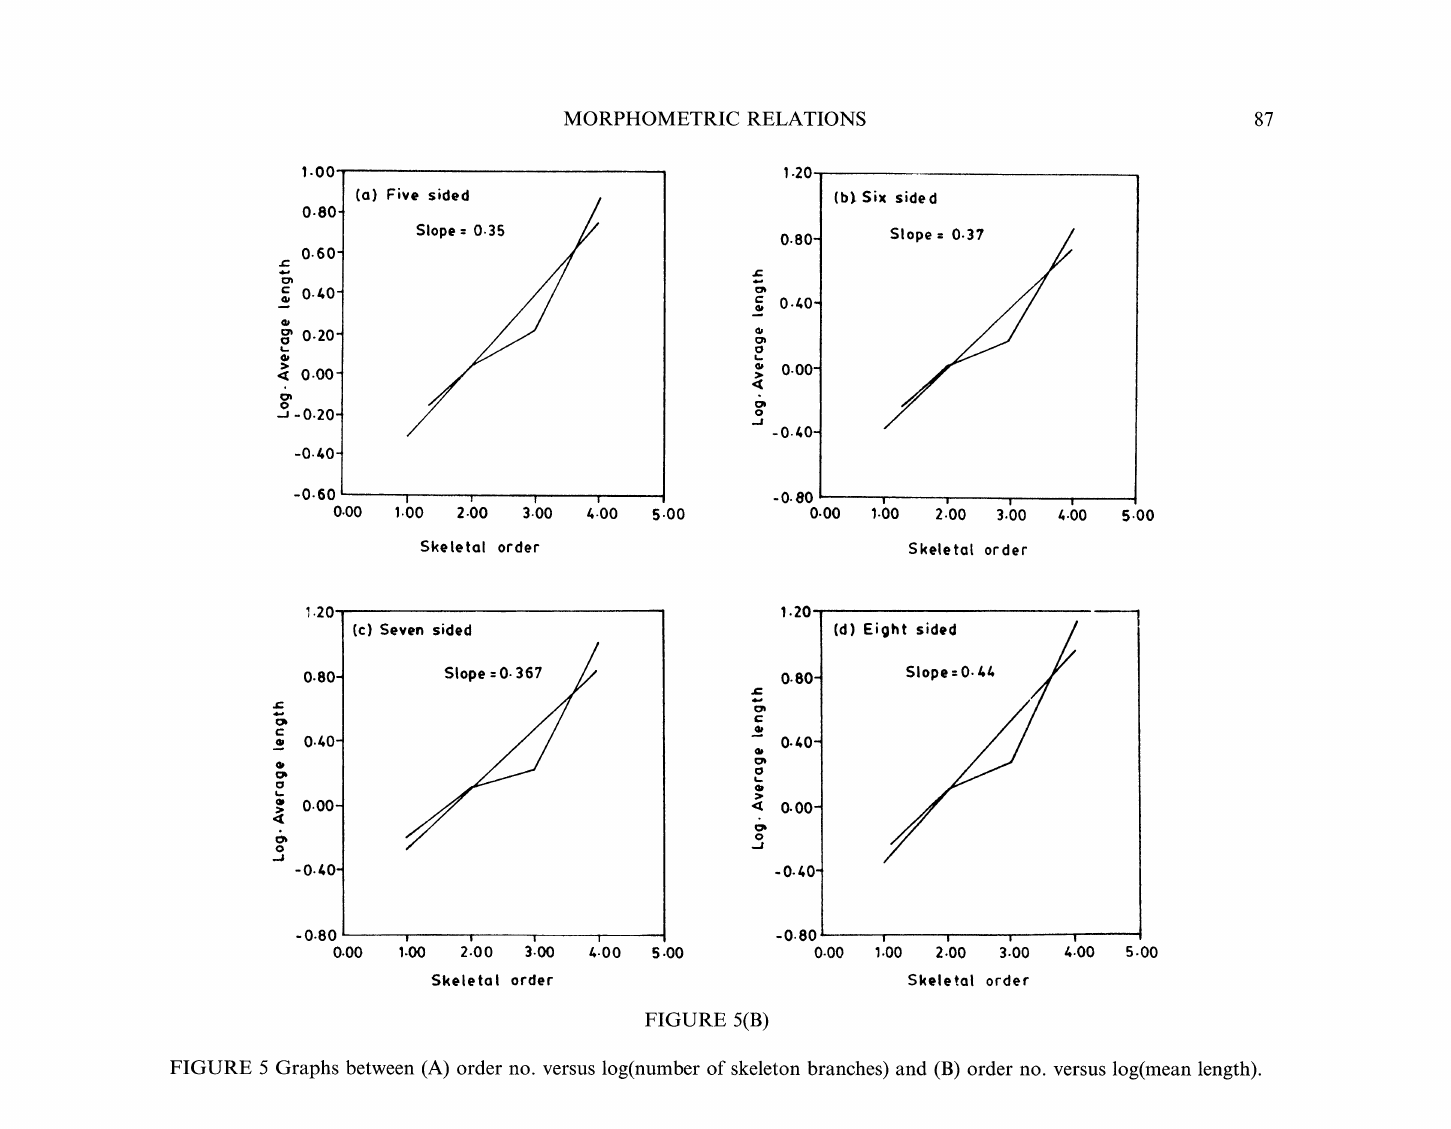
of these two types of plots viz. (a) order versus number, (b) order versus mean lengths were arrived at. The slope values for the plots between order and number are -0.48 for all the considered channel network patterns. In contrast, the slope values for the plots between the order and the mean channel lengths are 0.35, 0.37, 0.37, and 0.44 for the channel networks of generated fractal basins